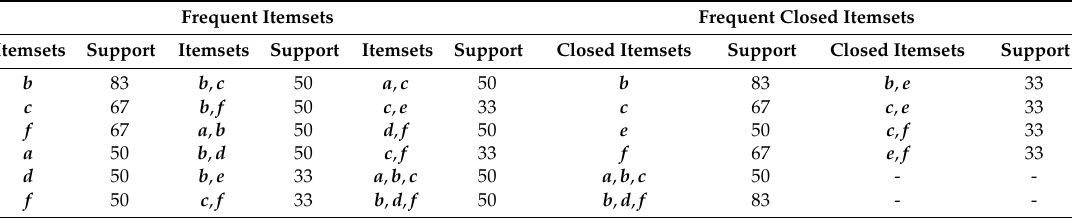
Table 1. Comparison table of frequent itemsets and frequent closed itemsets for Figure